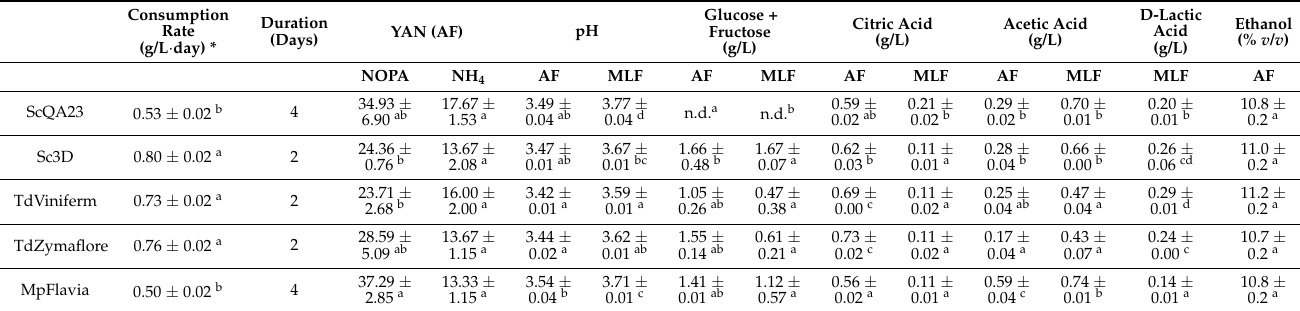
Table 2. Malolactic fermentation (MLF) parameters and concentration of various oenological compounds in natural grape wines. AF and MLF refer to the sampling point after alcoholic fermentation and MLF, respectively. YAN means yeast assimilable nitrogen.